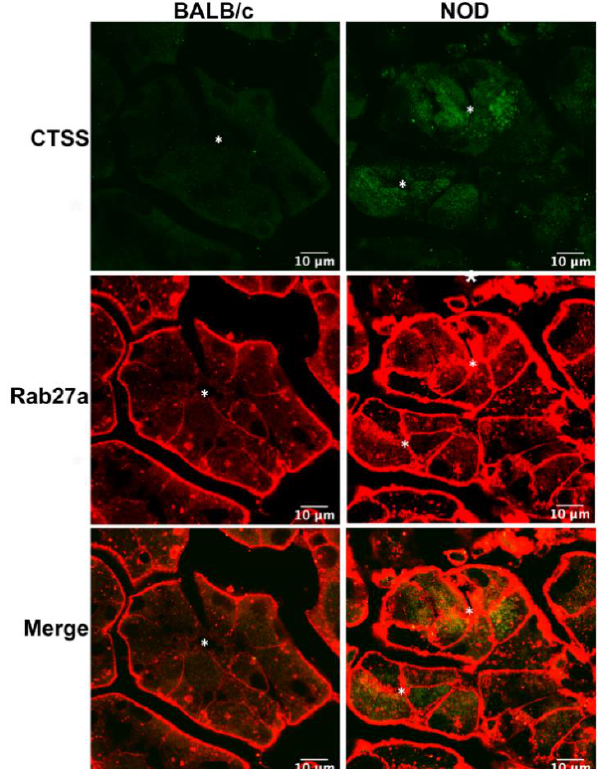
Figure 1. Increased enrichment of CTSS and Rab27a in vesicles in LGAC from male NOD mice. CTSS and Rab27a distribution in LGAC from LG from 16–17 week male BALB/c and NOD LG sections were characterized by immunofluorescence. CTSS immunofluorescence intensity (green) was clearly increased in NOD mouse LG sections, while also showing an increased colocalization with Rab27a (red) in the subapical area. Staining adjacent to the plasma membrane was observed for Rab27a due to secondary anti-mouse antibody reaction with residual interstitial immunoglobulins. In order to visualize intracellular Rab27a above this high interstitial background, the fluorescence signal in the interstitium was acquired under conditions of saturation. N = 4, N = number of mice. *, Lumen.